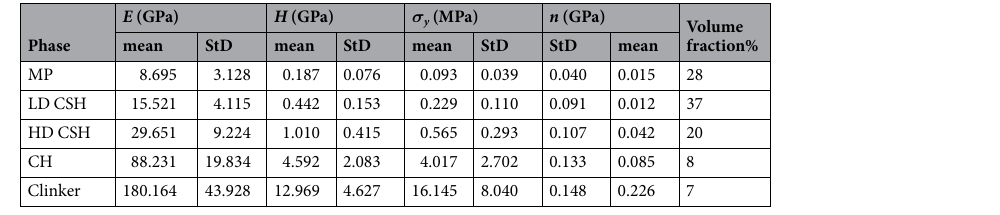
Table 1. Deconvolution results of OPC